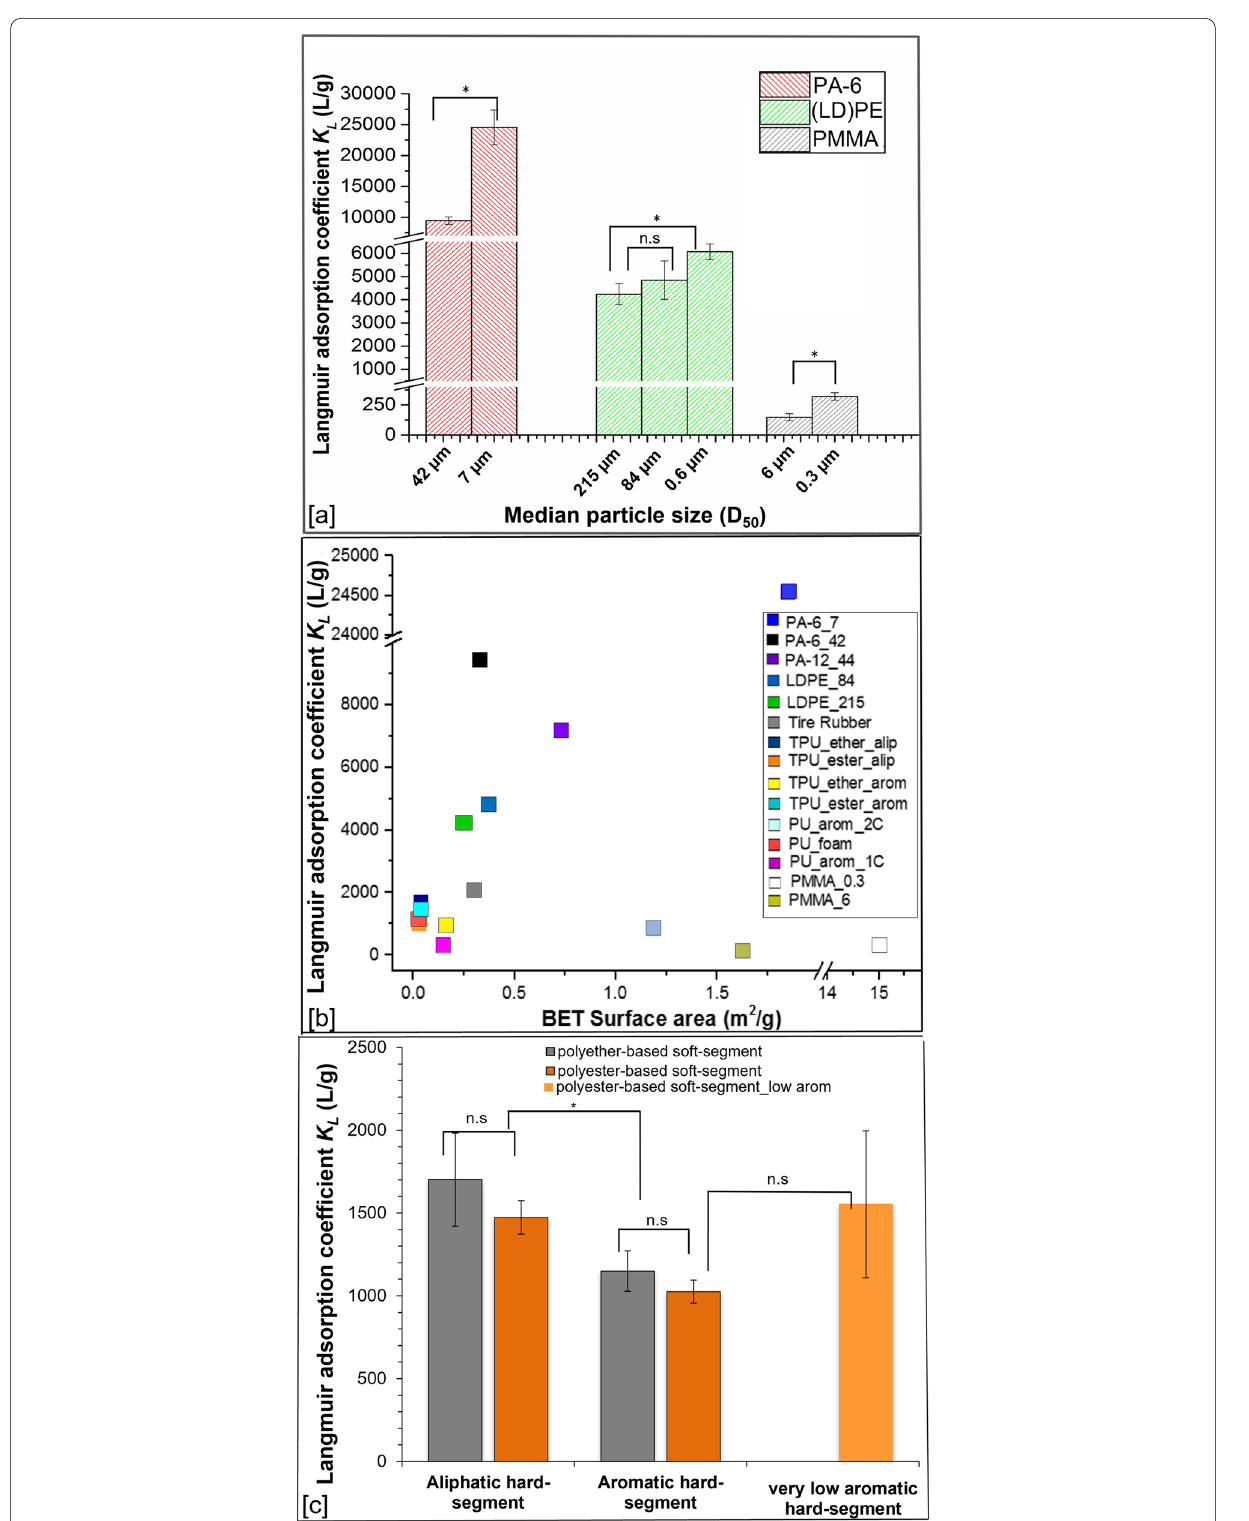
Fig. 4 a Effect of particle size on the Langmuir adsorption coefficient K L for adsorption of B[ a ]P to MNPs of the same polymer type. b Plot of the dependency of K L on BET surface areas of MNPs. c Effect of TPU’s hard (aliphatic and aromatic) and soft (polyester or polyether) segments on K L . Error bars represent the standard error of K L (*: significantly different ( p < 0.05), n.s. not significant at =